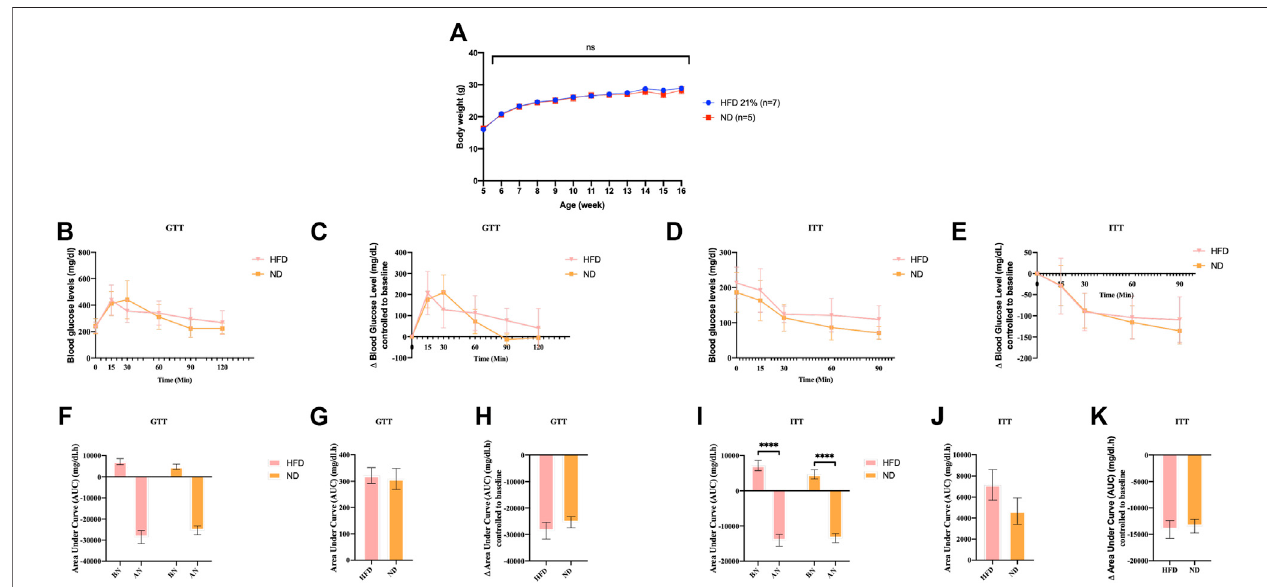
FIGURE 1 | Founder animals Dnmt2 − / − C57BL/6 are resistant to high-fat diet. Thirty-six Dnmt2 − / − C57BL/6 males ( C57Bl/6 background) from 20 litters weaned at 4 weeks old were divided into two groups. One group was maintained on an ND, and the other group was on HFD containing 21% (Figure 1-1) or 33% (Figures 1-2) , butter (see Methods) and monitored for body weight (A) , fasting blood glucose (B,C) , and insulin tolerance test (D,E) at 15 weeks. The area under curve (AUC) (Virtue and Vidal-Puig, 2021) (F – K) was also calculated after normalization based on the glucose levels of each time point to 0 point (HFD and control ND), before normalization (BN) and after normalization (AN). Statistical analysiswas performed by two-tailed, two-wayANOVA, uncorrectedFisher ’ sLSD. **p < 0.01, ****p < 0.0001 (ND vs. HFD), ns, not signi fi cant. All data are plotted as mean ± S.E.M. The raw data are presented in Supplementary Table S1 and individual raw data in Supplementary Table for Figure 1 .